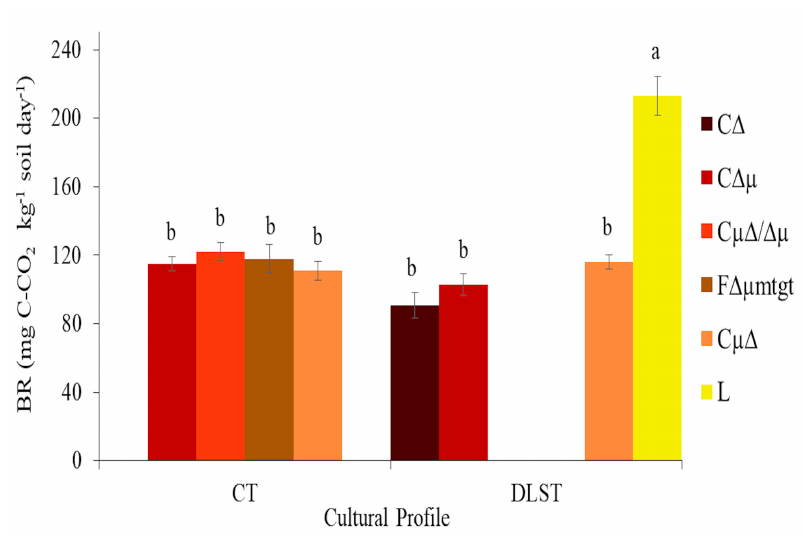
Figure 7. Basal respiration (BR) in a dystrophic Red-Yellow Latosol under conventional tillage (CT) and deep localized soil tillage (DLST). Organization of clods: L = free soil volume, C = continuous soil volume, F = cracked soil volume, NAM = unaltered soil volume by use and management, mt = medium clods (7 cm Ø), gt = large clods (10 cm Ø). Internal states of clods: μΔ = porous with indications of compression, μΔ/Δμ = medium porosity, Δμ = compact with some porosity, Δ = compact with no visible porosity to the naked eye. Bars indicate the mean standard error. Volumes of soil with the same letter for different soil tillage systems did not differ statistically in Tukey’s test (p ≤